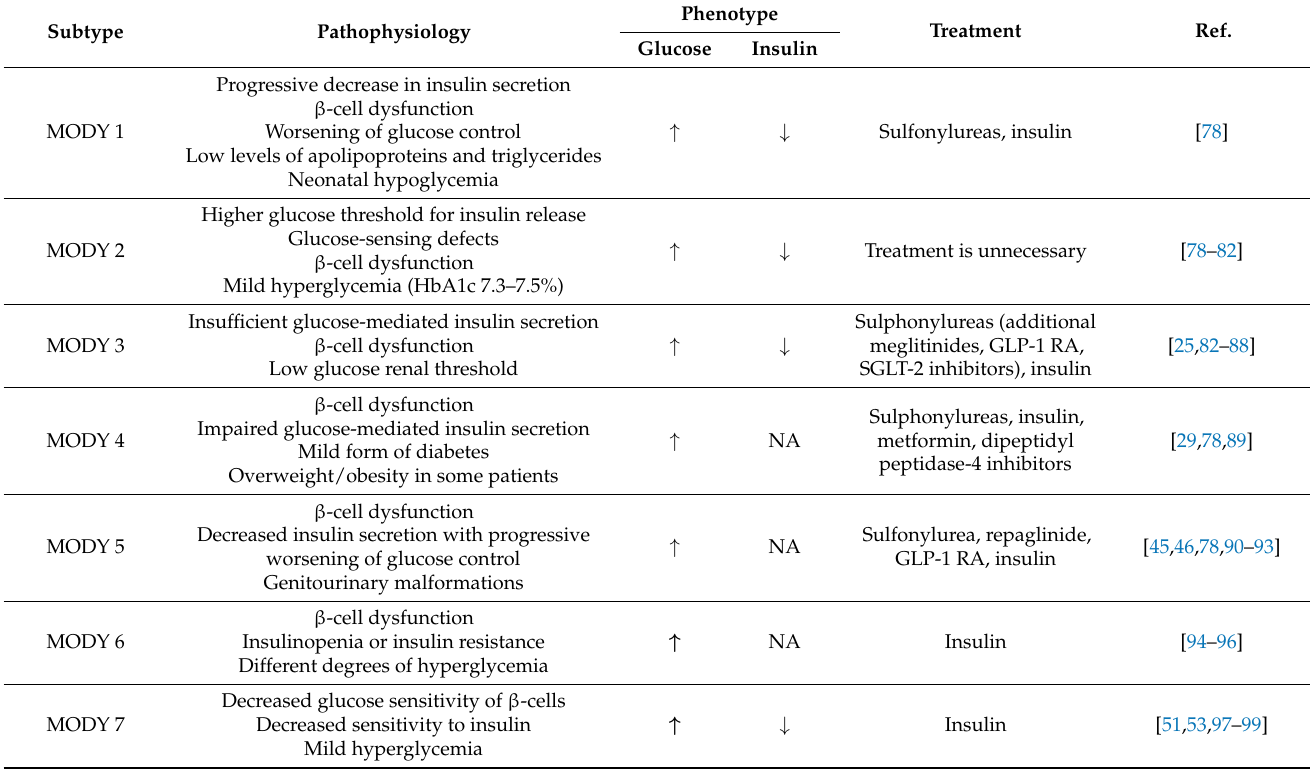
Table 2. Pathologies, phenotypes, and treatments of MODY